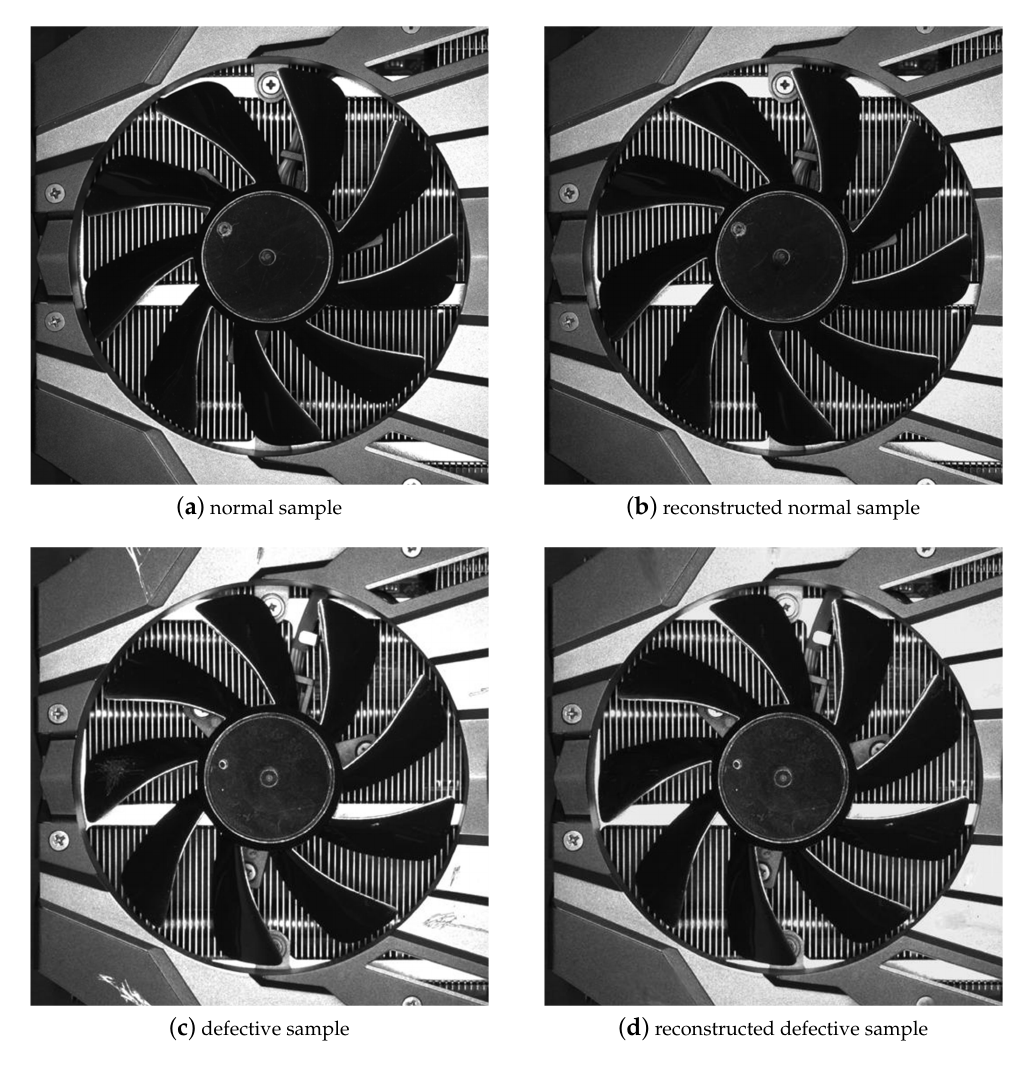
Figure 13. Examples of the input test images and their reconstructions by the AE for the backplate surface of a display card: ( a ) normal test sample; ( b ) reconstructed normal test sample by the AE; ( c ) defective test sample; ( d ) reconstructed defective test sample by the